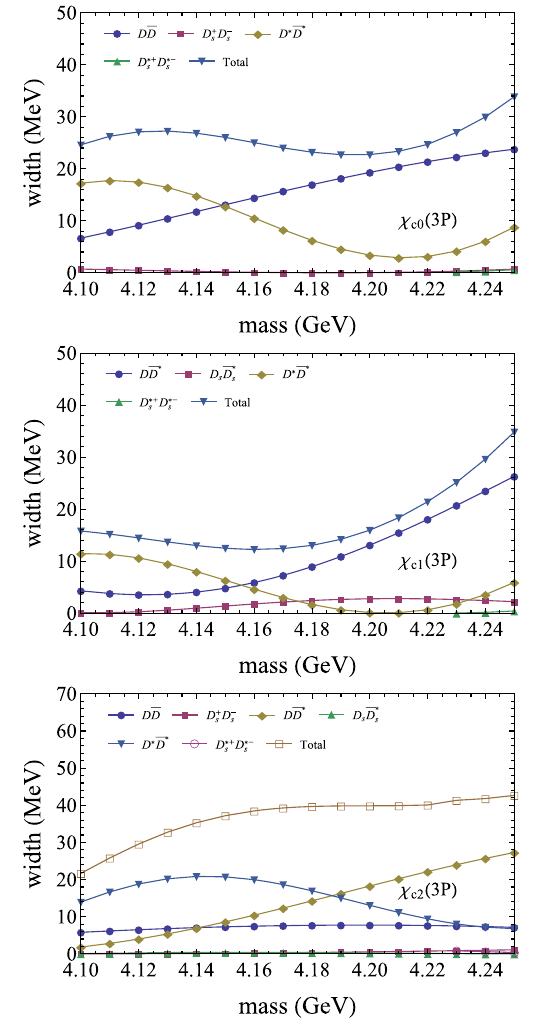
Fig. 2 The dependences of the widths of χ c 0 ( 3 P ) , χ c 1 ( 3 P ) and χ ( 3 P ) on the initial state mass with the wave functions of Case c 2